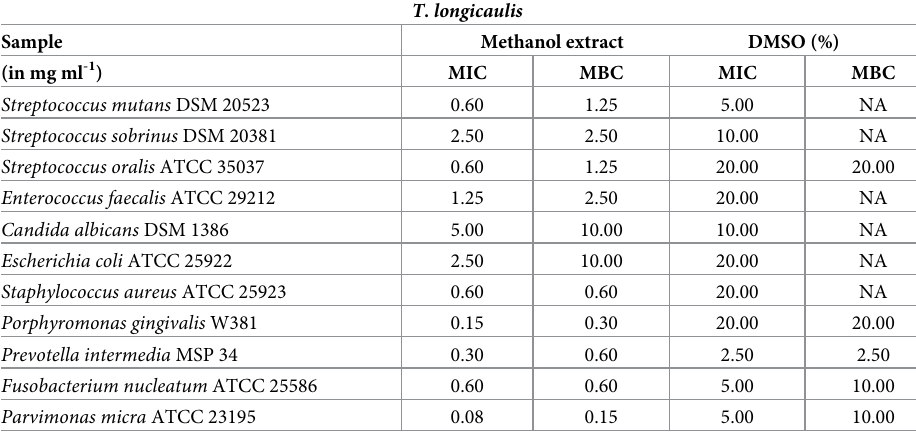
Table 12. Antimicrobial activity in mg ml -1 of T . longicaulis methanol extract.